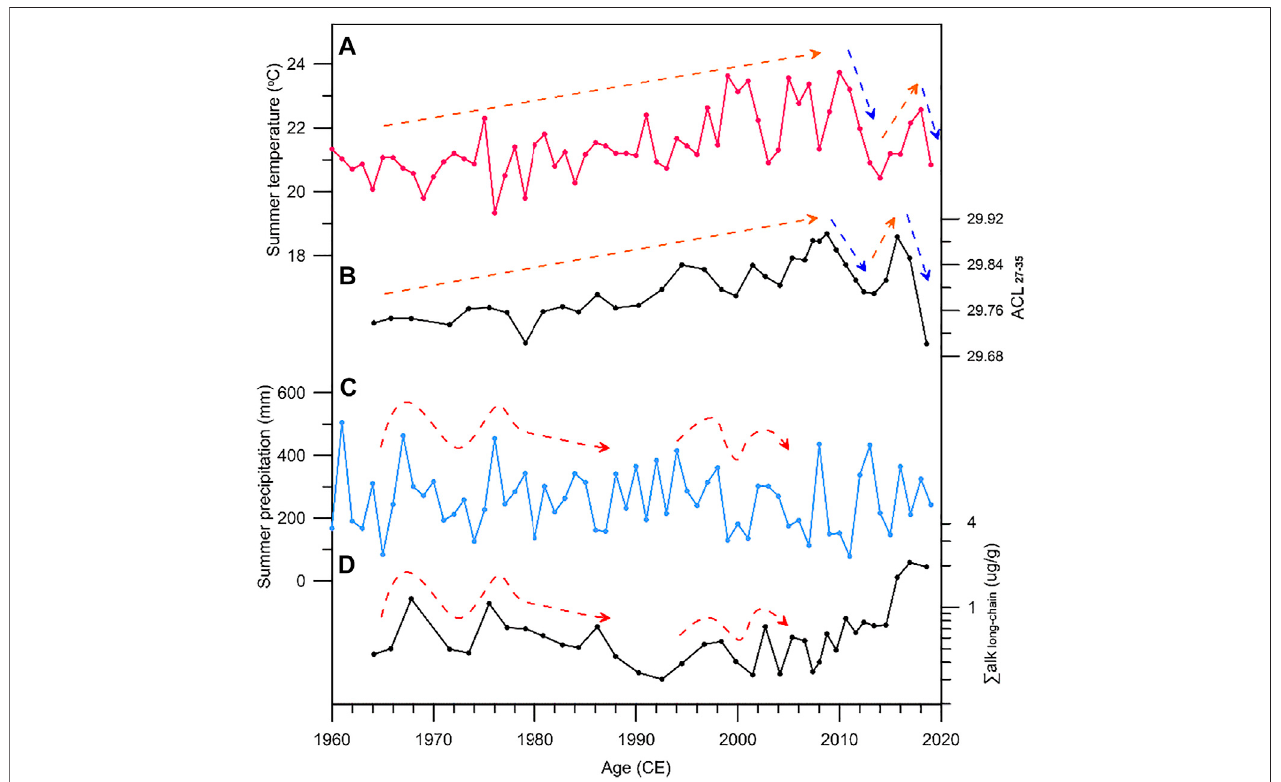
FIGURE5| Comparisonsofclimaticvariablesand n -alkaneresultsoverthelast60years. (A) Summertemperature; (B) ACL 27 – 35 record; (C) summerprecipitation; and (D) (cid:1) alk long-chain record (the y -axis is a logarithmic coordinate). Meteorological data are from the Hohhot Weather Station (www.cma.gov.cn).